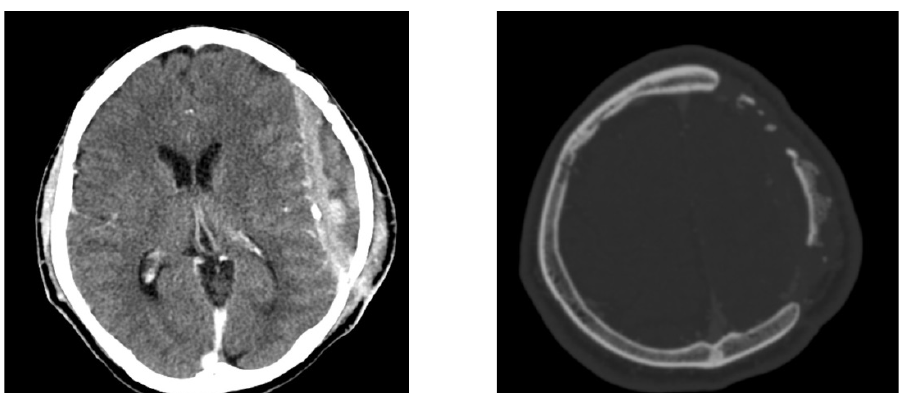
Figure 3. Brain contrast-enhanced computed tomography images show erosion of the bone flap and